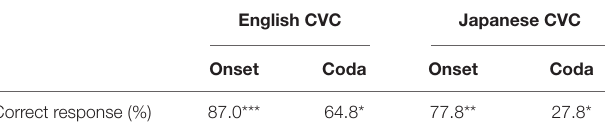
TABLE 3 | Audio-only accuracies for onsets and codas in CVC stimuli.